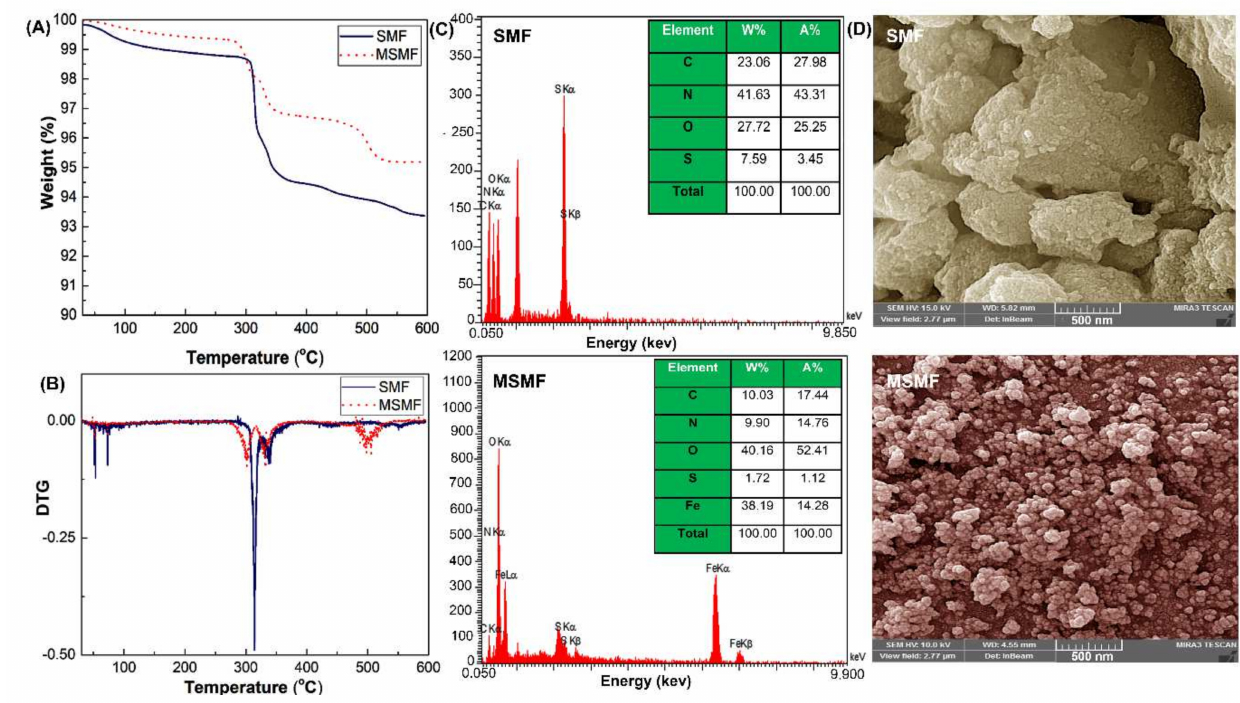
Figure 3. TG ( A ) and DTG ( B ) curves, EDX spectra ( C ), and FESEM ( D ) micrographs of SMF and